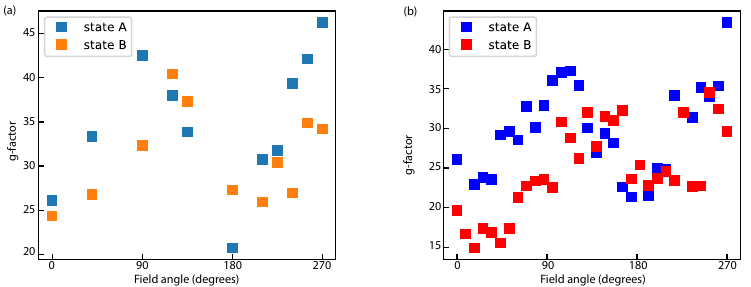
Figure S4: Two methods for calculating effective g-factors: a directly extracting Zee- man energy at B = 1T the height of diamonds A and B in Fig. S5; b From data in Fig. S5 using the lever arm between gate voltage and bias voltage from Fig. S5. Data for state A are used in Fig. 4. States A and B are labeled in Figs. S4 and S5 and correspond to adjacent orbitals of the same quantum dot. The two methods yield qualitatively the same results but disagree quantitatively largely due to charge instabilities seen in Fig. S5.